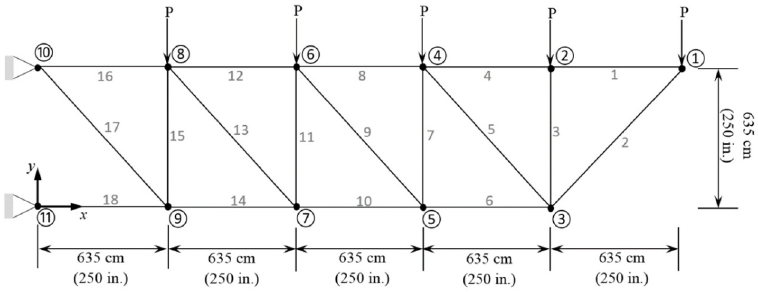
Fig. 5. Schematic of the planar 18-bar truss